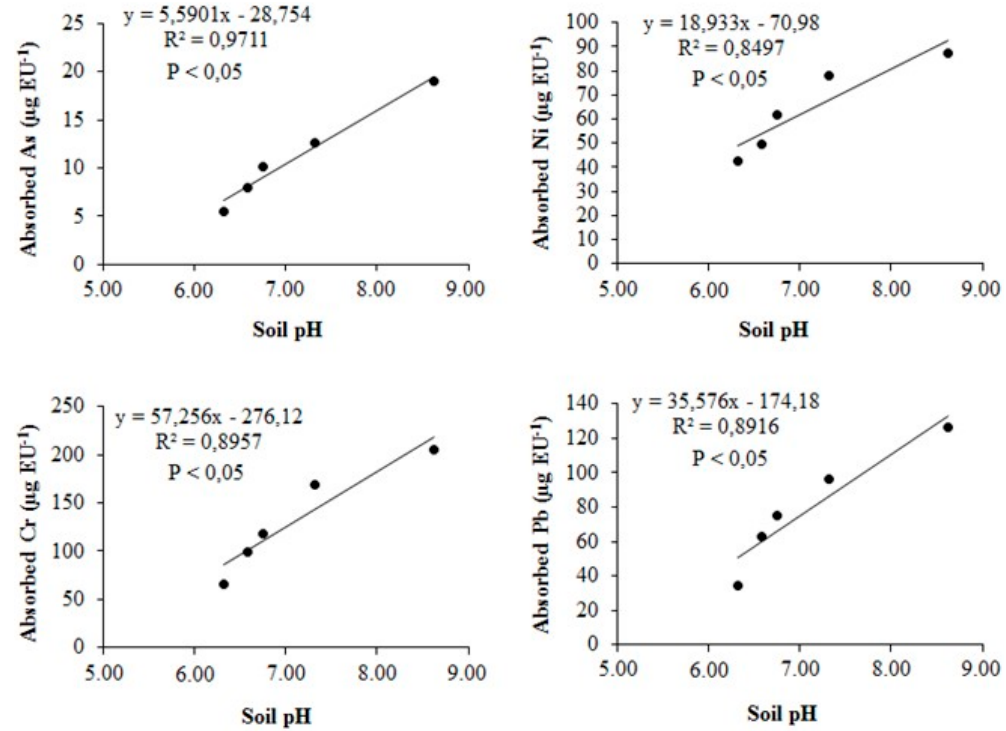
Figure 4. Linear relationship between the heavy metal(oid)s absorbed by ryegrass ( Lolium perenne L.) and soil pH as an effect of wood ash treatments in the Ultisol. Absorbed metal is the sum of total metal in the root and aerial shoot parts of plant. Soil pH at 1:2.5 (w/v) corresponding to five treatments (Control and WA 7.5, WA15, WA30, and WA75 are shown in this same order in each graph). Changes in soil pH additionally affect the plant rhizosphere. Navarro-Aviñó et al. [5] reported